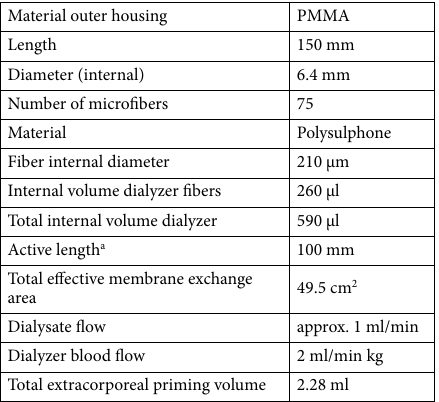
Table 1. Technical specifications of the micro-dialyzers used in the experiments. All components have been built and designed in-house, polysulphone fibers were harvested from conventional clinical hemodialyzers. a Length of dialyzer fibre section involved in fluid/solute